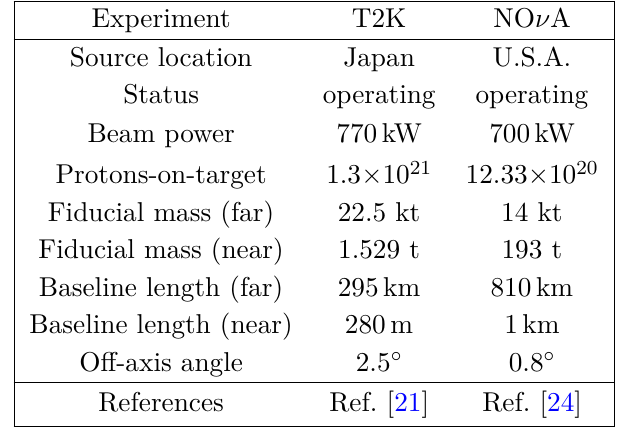
Table 2 . The long-baseline neutrino experiments simulated in this study.